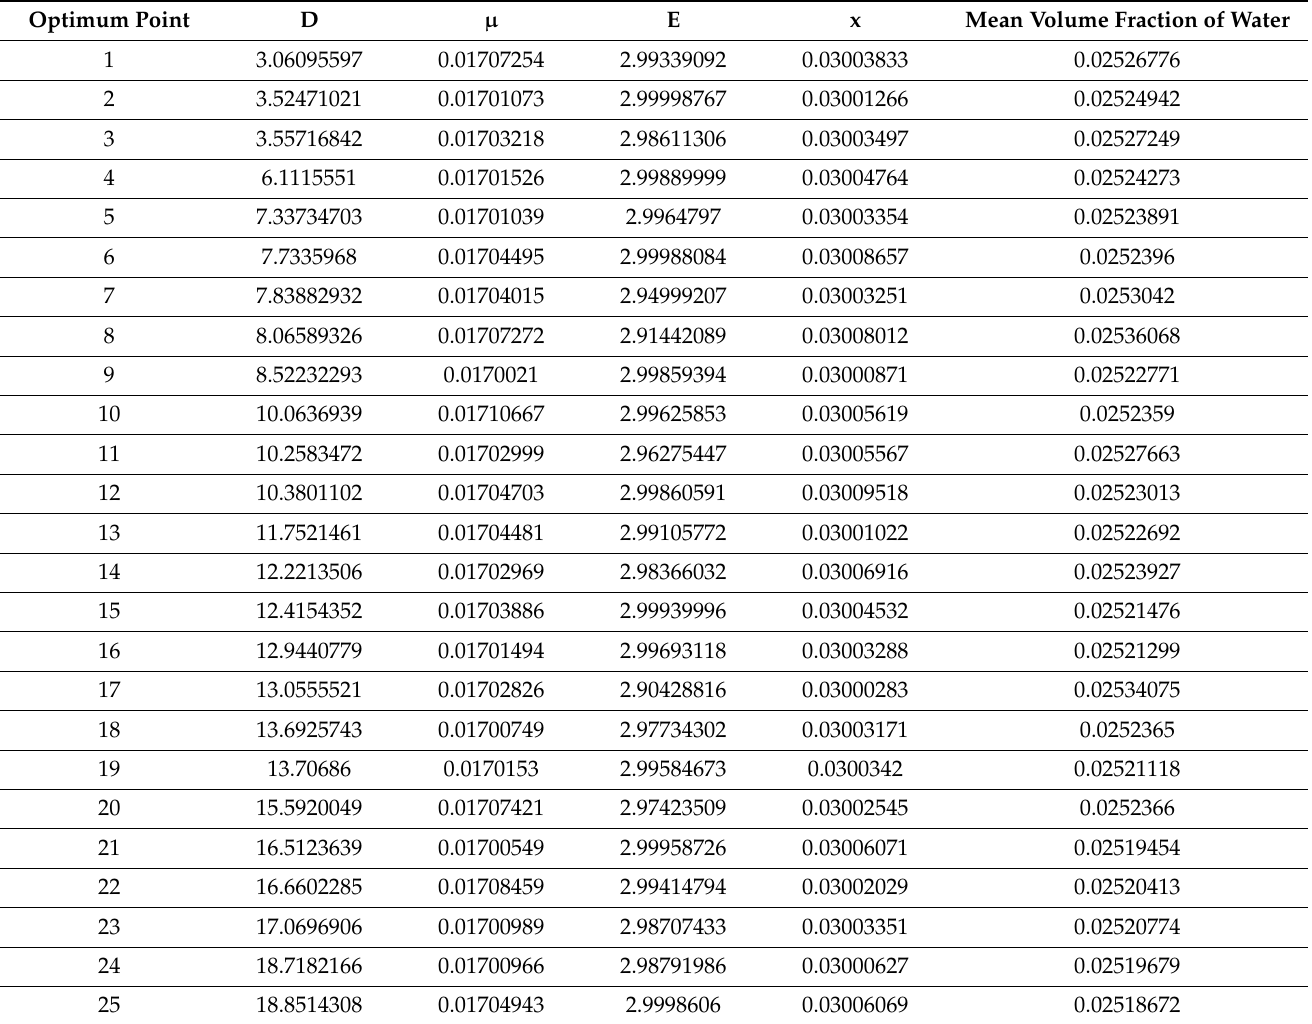
Table 8. Pareto front with